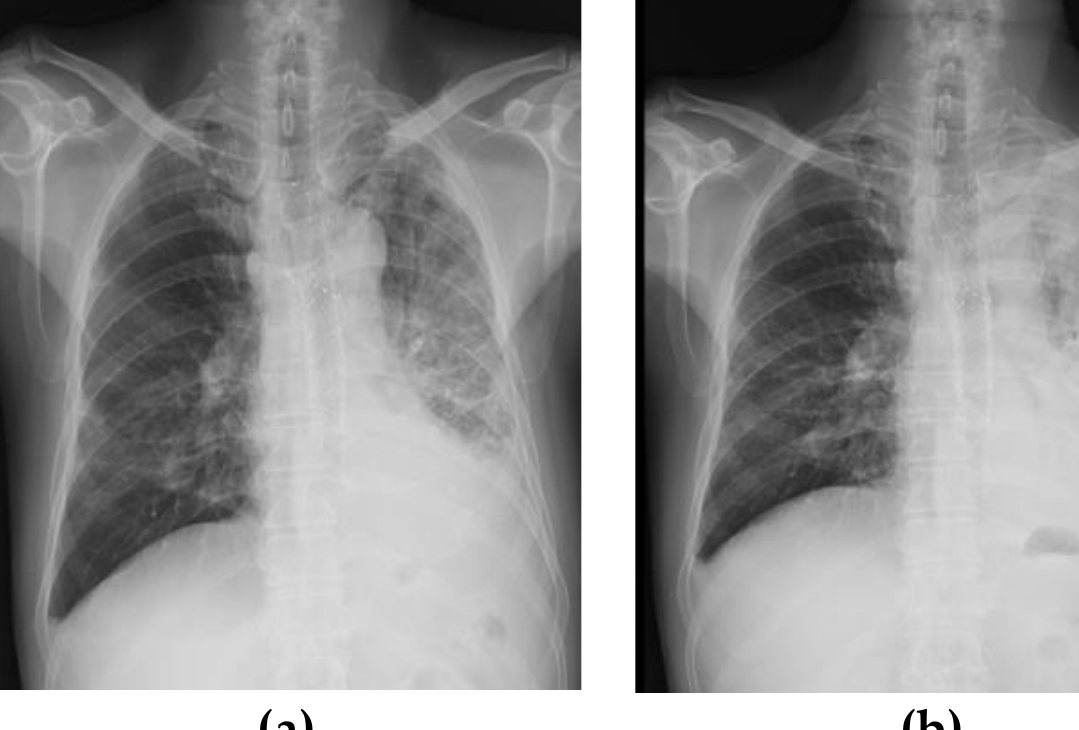
Figure 2. ( a ) Initial chest x-ray in the emergency room. Despite antibiotic treatment, the patient complained of worsening dyspnea. ( b ) Follow-up chest X-ray taken 7 days after hospitalization showed a white-out of the left hemithorax.